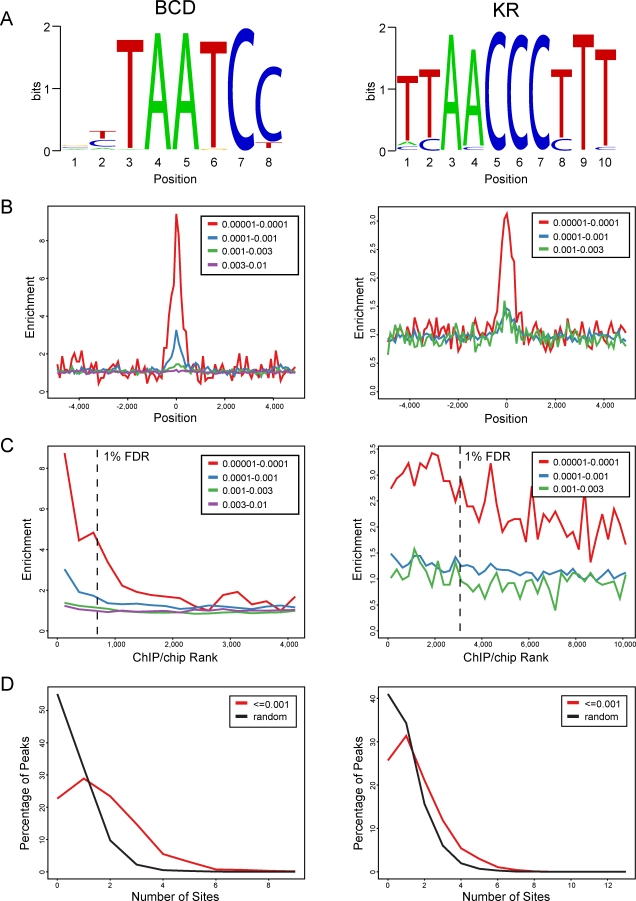
Recognition Sequences Are Modestly Enriched in Bound Regions(A) Sequence logo representing the BCD and KR PWMs derived from SELEX data (made with seqlogo [99]).(B) Fold enrichment of matches to the PWM from (A) in 100-bp nonoverlapping windows across the 1% FDR primary peaks, with the peaks at position zero on the x-axis. PWM matches shown are divided in subsets based on the p-value of their match to the matrix.(C) Fold enrichment of matches to the PWM from (A) in the 500 bp around (±250 bp) regions around primary peaks, in nonoverlapping windows of 250 peaks down the ChIP/chip rank list to the 25% FDR cutoff. The 1% FDR cutoff is indicated as a vertical dotted line. As in (B), matches are divided based on the significance of their match to the matrix.(D) shows the distribution of the number of sites in the 500-bp (±250 bp) regions around 1% FDR primary peaks and, for comparison, randomly selected noncoding genomic sequence. In this panel, a match to the matrix is defined as having a PATSER p-value of ≤0.001.